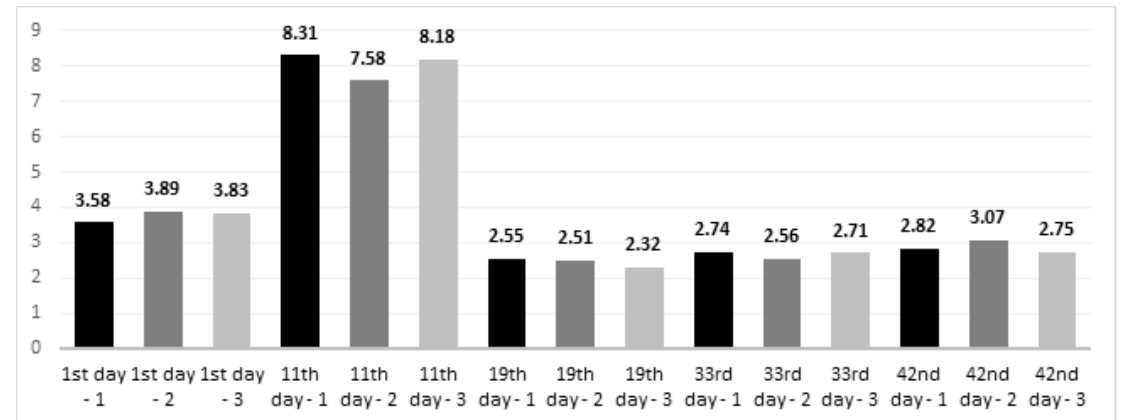
Figure 1. pH of the litter. Notes: 1—control group; 2—group with halloysite in the litter; 3—group with zeolite in the litter; 1st day—stater feed period; 11th day—grower 1 feed period; 19th day—grower 2 feed period; 33rd day—finisher feed period; 42nd day—slaughter day; sampling was performed once on the mentioned days.*no significant differences be- tween groups were found ( p > 0.05); mean values from various days were significantly different, with p -value < 0.05.